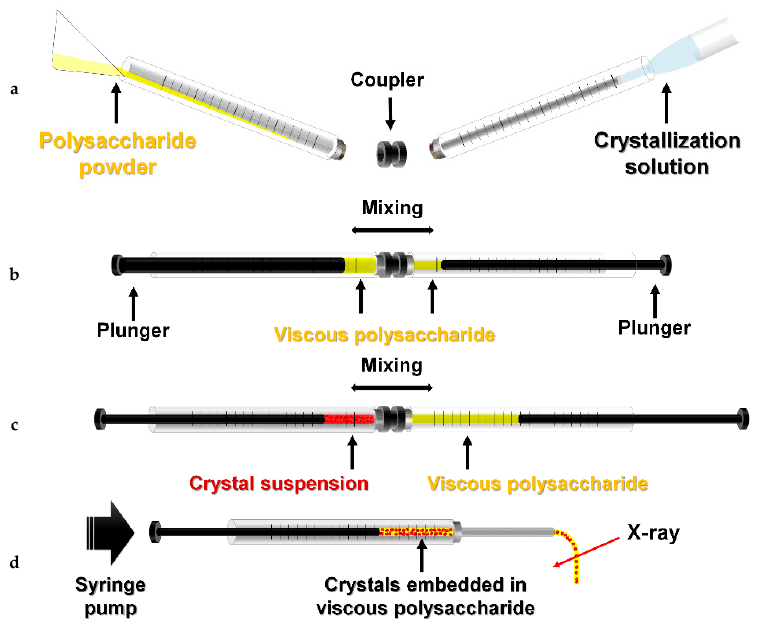
Figure 2. Preparation of WS and alginate delivery media for SX. ( a ) Wheat starch (WS) or alginate powder was added to a 250 μ L syringe and crystallization solution to a 100 μ L syringe. ( b ) WS or alginate was mixed with crystallization solution in a dual syringe setup. ( c ) Viscous WS or alginate was mixed with the crystal suspension. ( d ) After connecting the syringe needle, crystals embedded in the viscous medium were delivered to an X-ray interaction point using a syringe pump. WS or alginate (5–20% w / v ) was prepared, and the injection stability was initially screened using a syringe with a 168 μ m inner diameter (ID) needle at a flow rate of 200 nL/min. At WS and alginate concentrations less than 8%, the injection stream was unstable or often presented drop-like formations at the tip of the needle (Figure 2b). WS and alginate showed stable injection streams at